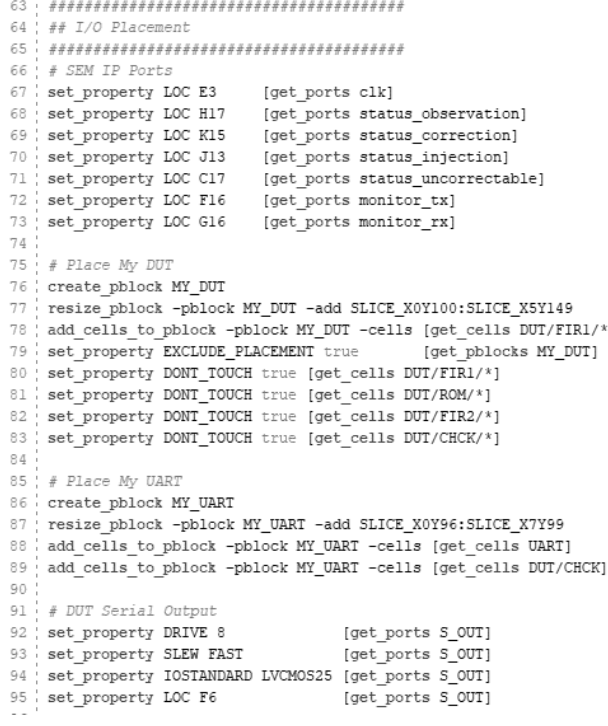
15 of 24 Figure 14. Pmod connectors. Front view. Table 3. Nexys4 DDR Pmod pin assignments. Pmod JA